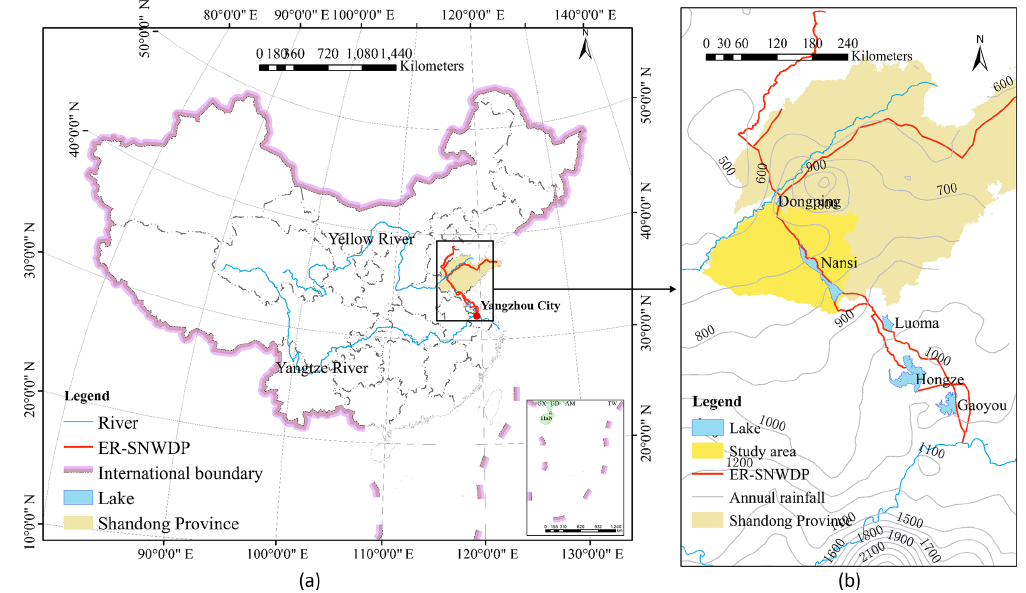
Figure 1. Sketch of the eastern route of the South-North Water Transfer Project (a) . Annual rainfall contours and lakes along the route (b) .